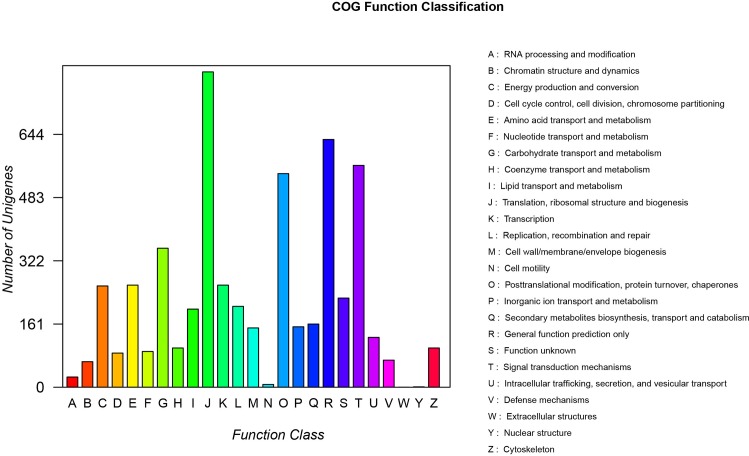
COG functional categories of P. heterophylla.